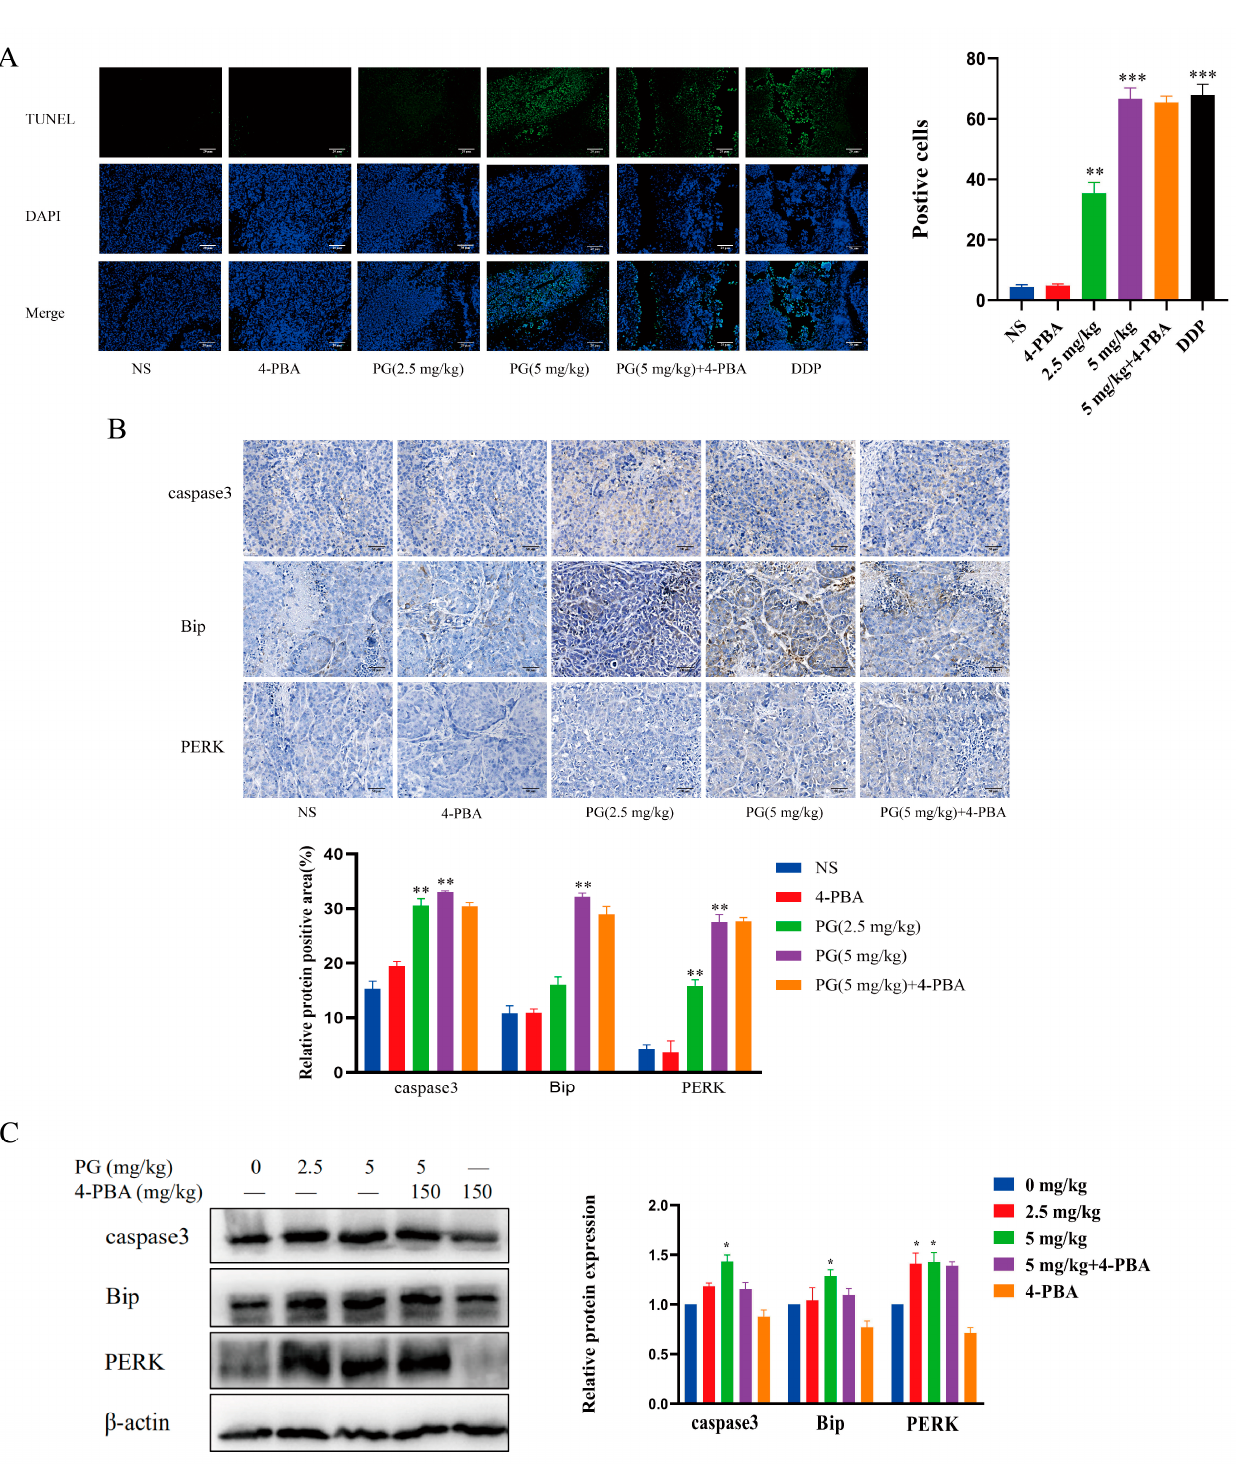
Figure 8. The effect of PG on the apoptosis in the tumor xenografts of HepG2 HCC model. ( A ). TUNEL assay for the apoptotic property of PG on HCC; ( B ). Immunohistochemical analysis for the effect of PG on the expression of caspase3, Bip and PERK in HCC tissue; ( C ). Western blot for the effect of PG on the expression of Bip, PERK, and caspase3 proteins in HCC tissues. PG (2.5 mg/kg), PG (5 mg/kg) vs. PG (0 mg/kg), * p < 0.05, ** p < 0.01,*** p < 0.001, n = 3; PG (5 mg/kg) vs. PG (5 mg/kg) + 4-PBA, n = 3.